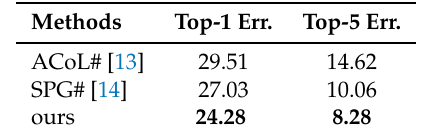
Table 3. Intersection over union (IoU) localization error (%) on the CUB-200-2011 test set. Methods Top-1 Err. Top-5 Err. CAM [7]